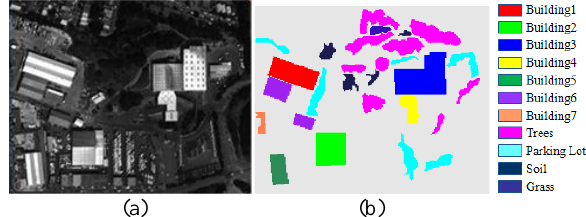
Figure 4. Recology data set. (a) RGB composite image of bands. (b) Ground truth map.